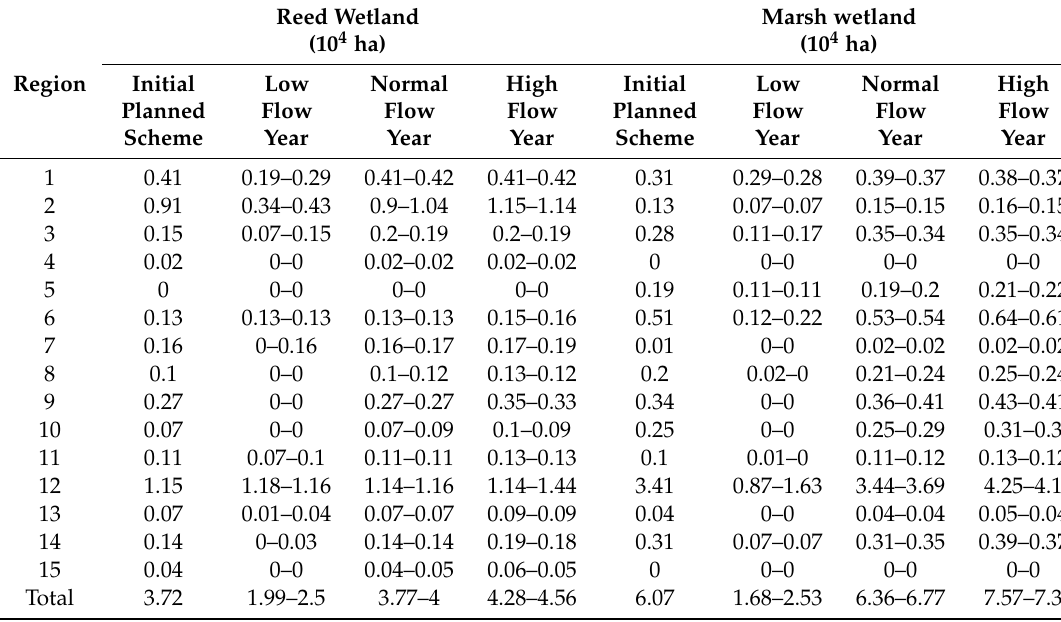
Table 2. Interval value of the reed wetland area and the marsh wetland